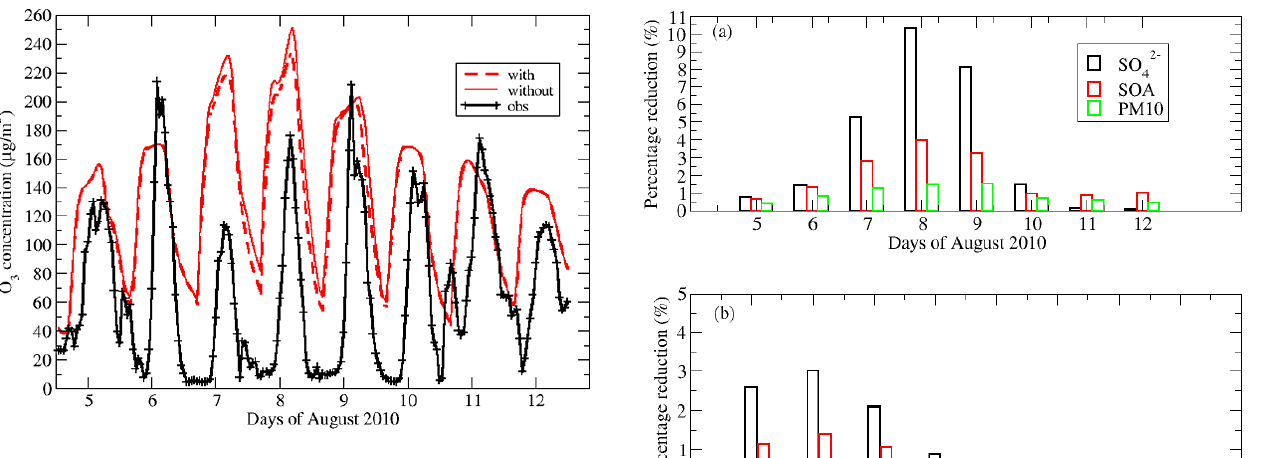
Figure 9. Temporal evolution (between 5 and 12 August 2010) of the near-surface ozone concentration (in µgm − 3 ) modeled with and without aerosol feedback along with corresponding observations at the Moscow monitoring station.